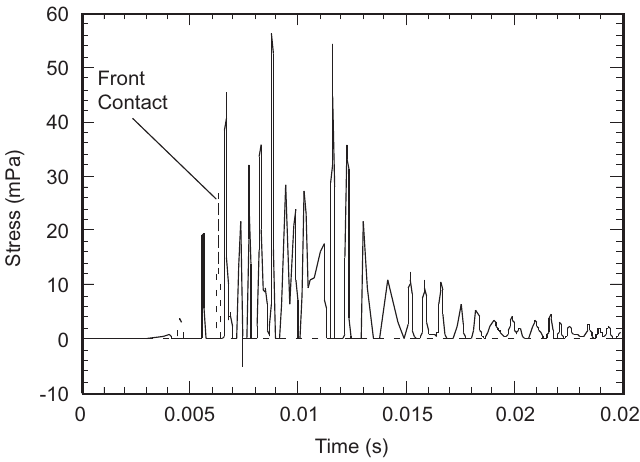
Fig. 5. Lug/front contact stress normal M203